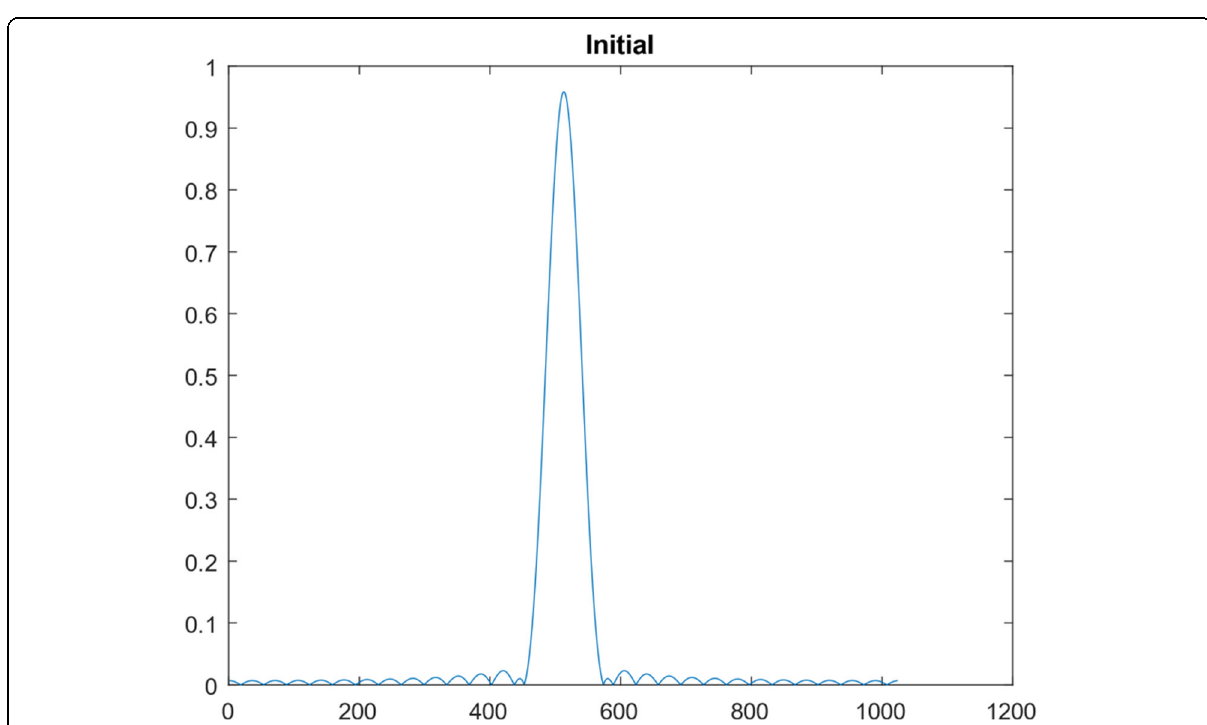
Fig. 12 The spatial-domain function obtained from the lowest 30 frequency components of the Gaussian